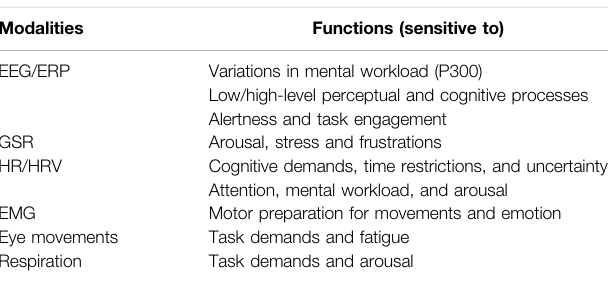
TABLE 1 | Physiological measures and a few of their